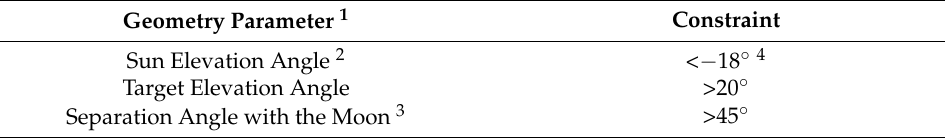
Table 2. Geometry constraints of an imaginary ground-based observatory.